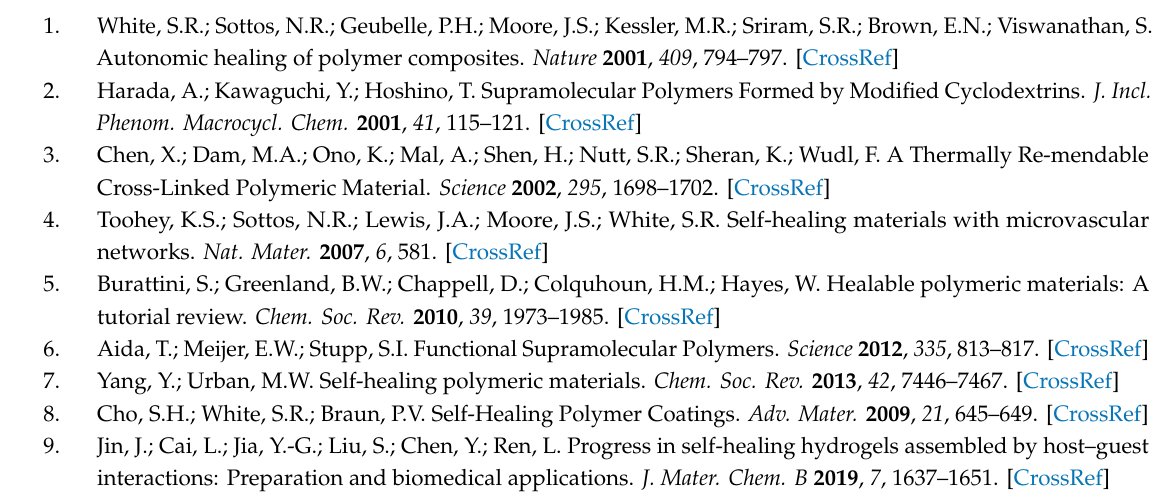
PU, Figure S12: ATR-FTIR spectra for G(10), Figure S13: DSC curve of TPU materials, Figure S14: The optical microscopy images of the initial damaged G(10) sample and after 7 min of heating by confocal laser microscopy, Figure S15: The scar profiles of G(10) as (a) width, (b) depth, and (c) area. (d) Self-healing ratio of G(10) calculated from the area, Figure S16: The optical microscopy images of the initial damaged HG(2.5) sample and after 7 min of heating by confocal laser microscopy, Figure S17: The scar profiles of HG2.5 as (a) width, (b) depth, and (c) area. (d) Self-healing ratio of HG(2.5) calculated from the area, Video S1: Self-healing test of HG(10) at 80 ◦ C after damaging with razor